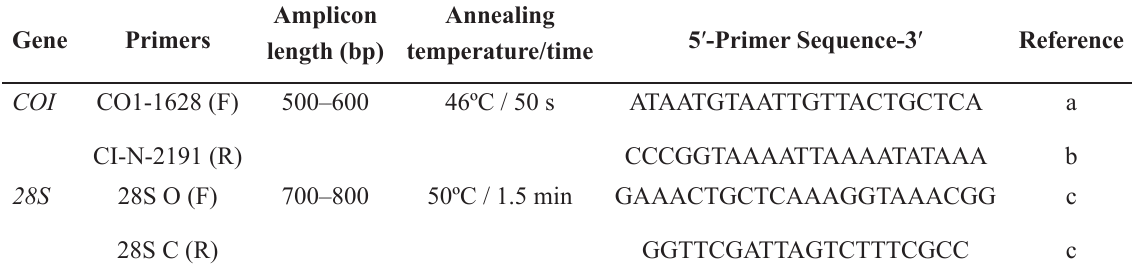
Table 2. Gene targets, PCR conditions and primer data used in this study. References: a = Simon et al . 1994; b = Dallas et al . 2005; c = Whiting et al .